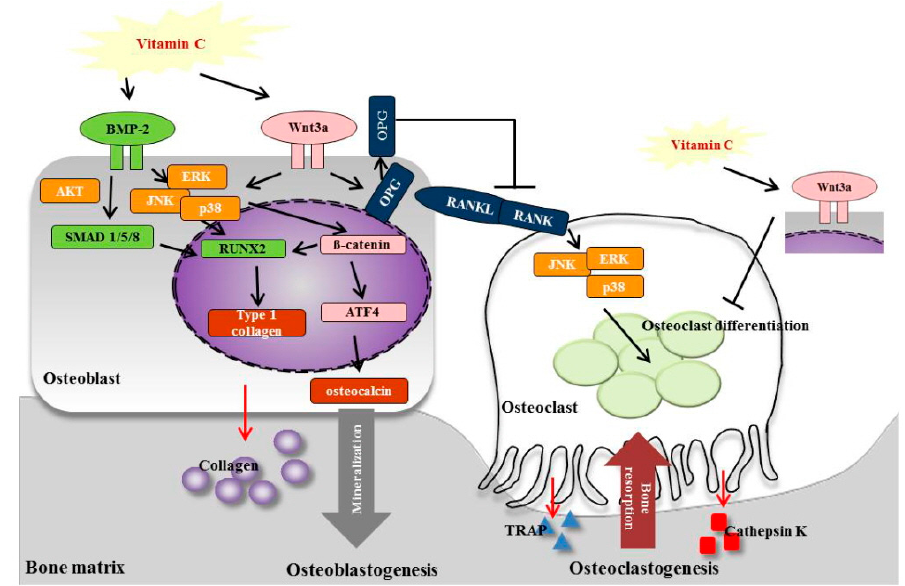
Figure 8. Scheme of vitamin C effects on osteoblastogenesis and osteoclastogenesis signaling pathways.